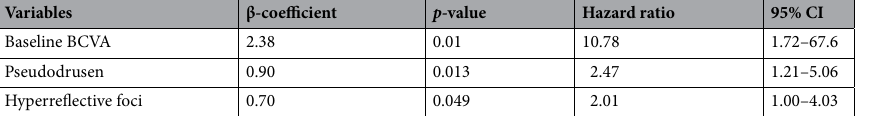
Table 3. Cox regression analyses associated with advanced AMD (repeated forward selection method). Age, sex, drusenoid pigment epithelial detachment, baseline subfoveal choroidal thickness, ARMS2 A69S, and CFH I62V were eliminated in this analysis. AMD, age-related macular degeneration; BCVA, best-corrected visual acuity.